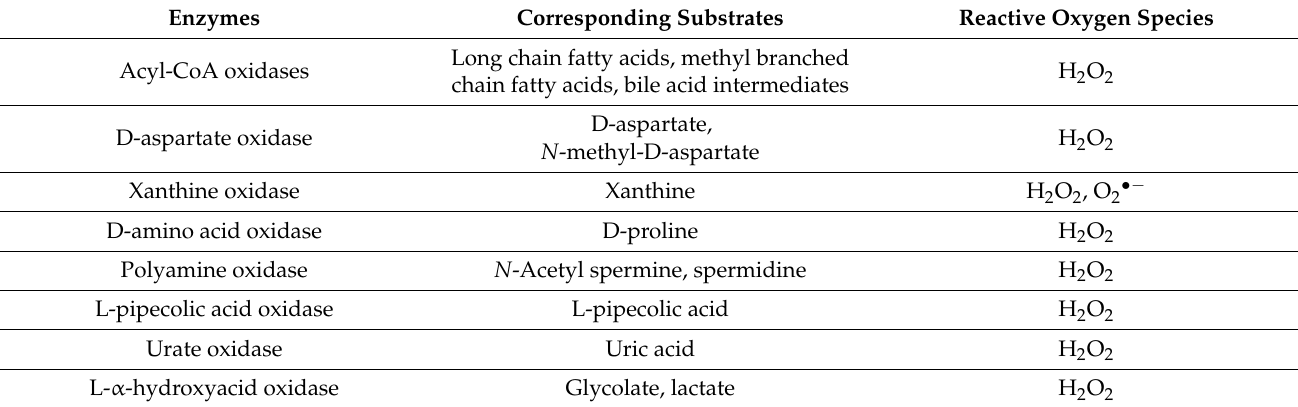
Table 1. Types of reactive oxygen species produced by several peroxisomal enzymes and their corresponding